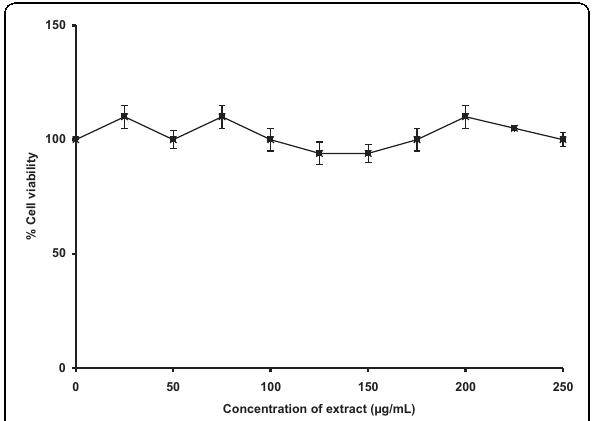
Figure 1 Effect of Spirulina extract on the viability of 3T3 cells . The cells were incubated with the extract for 72 h before being assessed for their viability. Data presented as mean ± standard deviations (n =